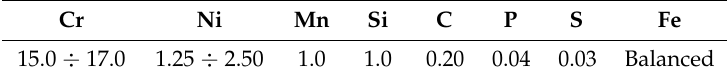
Table 1. Nominal chemical (wt.%) composition of base and fed